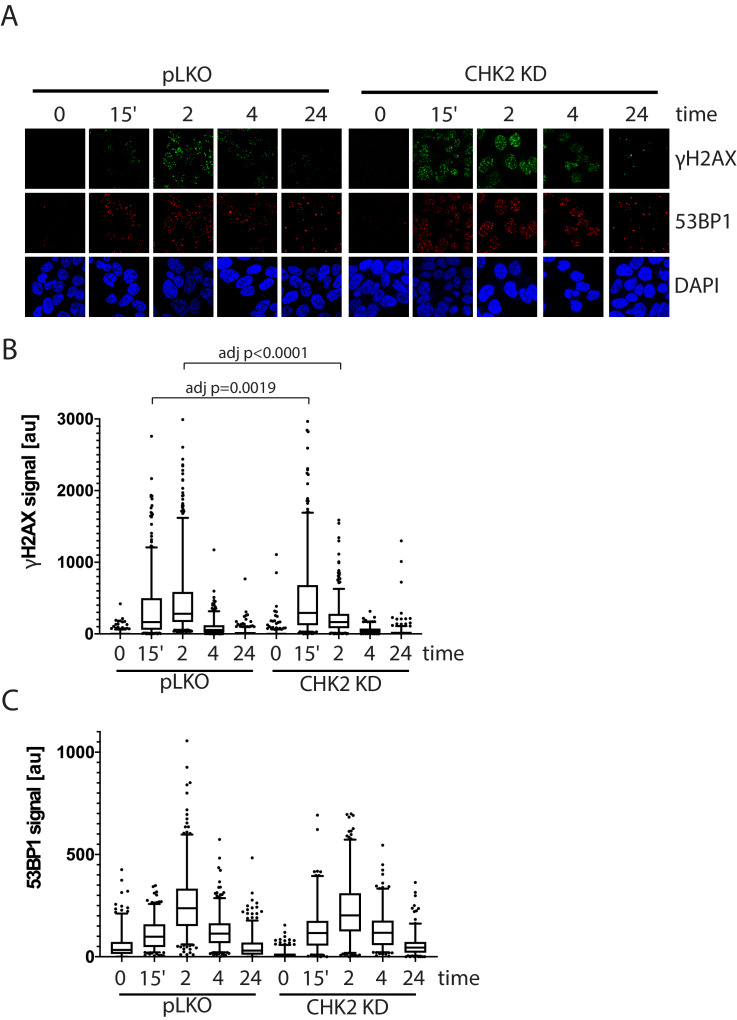
CHK2-depleted cells show altered γH2AX foci kinetics.(A) Representative images of γH2AX, CHK2, and AR immunostaining quantified in (B and C). (B) Rv1 cells were transduced with lentiviral particles expressing empty vector or CHK2 shRNAs on fibronectin-coated coverslips in the appropriate growth media. Cells were irradiated with 6Gy after 48 hr. Coverslips were processed for IF at 0, 15 min, 2, 4, and 24 hr following IR. Plotted is the (B) γH2AX signal and (C) 53BP1 signal, which equals the mean grey value intensity x number of foci per nucleus, n = 3 (378–565 nuclei measured per condition), 5–95% confidence intervals. Statistical differences were tested for using Kruskal-Wallis test followed by Dunn’s multiple comparisons test.